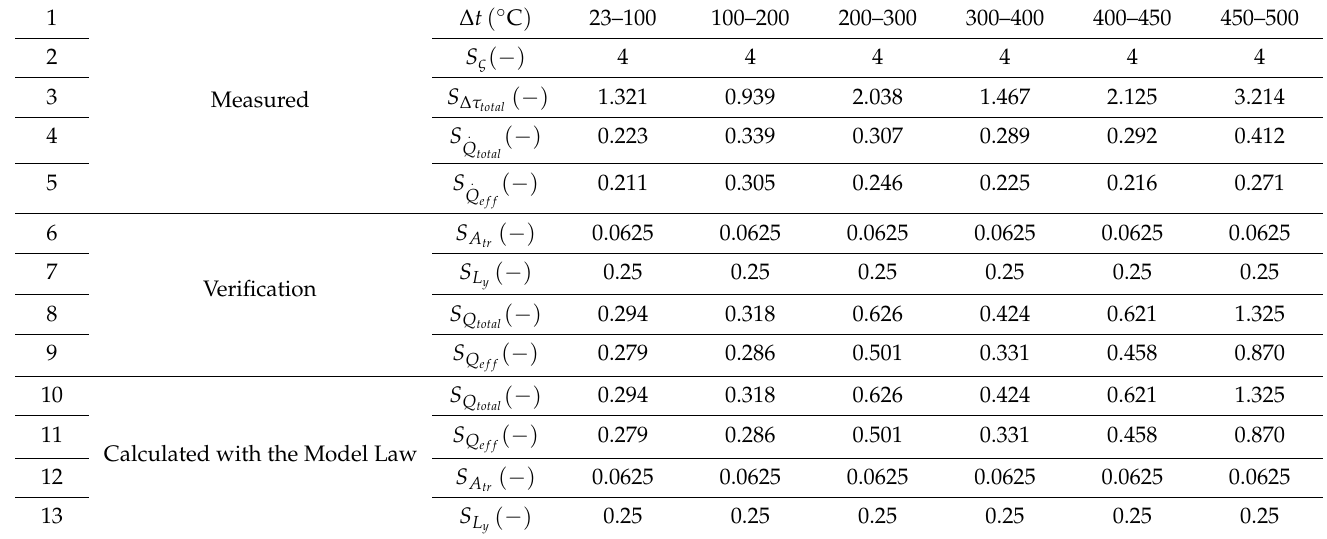
Table A13. The 1:4/1:1 painted